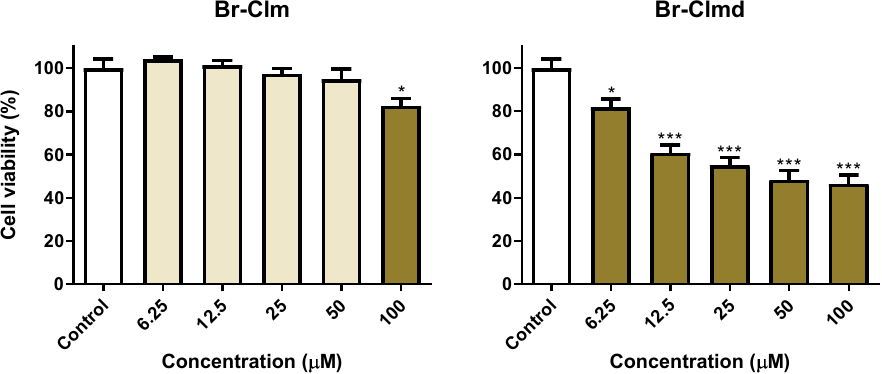
Figure 4. Viability of HaCaT cells exposed to Br-Clm or Br-Clmd in the 6.25–100 µ M range for 24 h. Statistical analysis was conducted between each treatment and the control. * p < 0.05, *** p < 0.001.